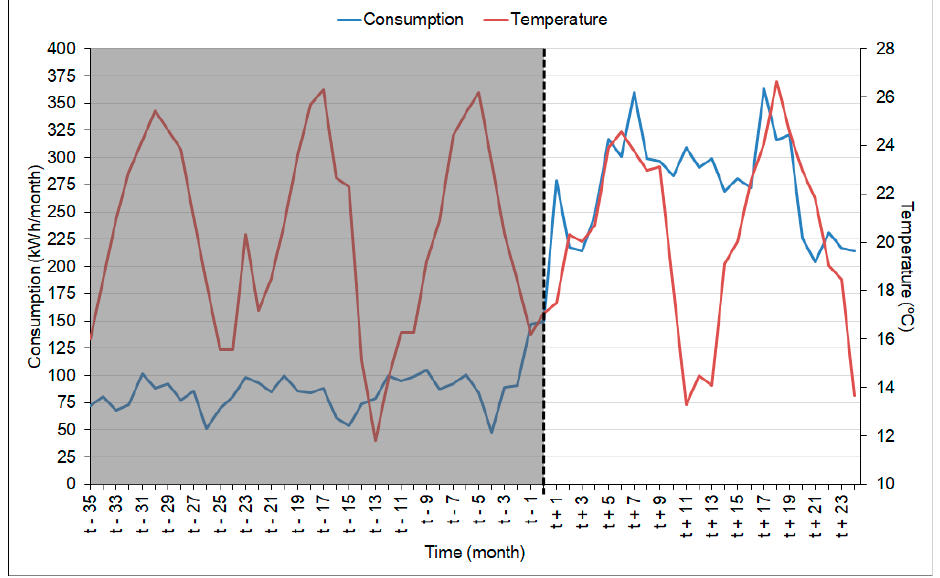
Figure 3. Consumer with NTL (fraudulent behavior highlighted).